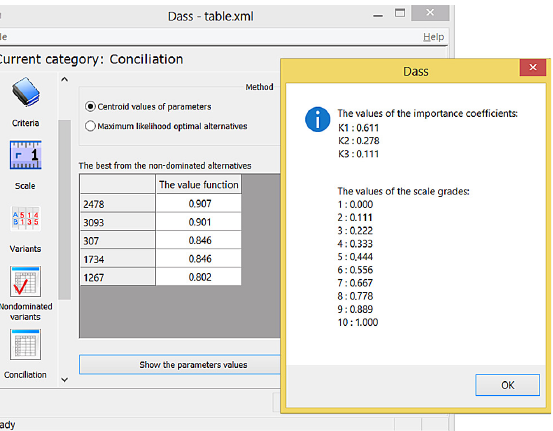
Figure 6. Estimation of value functions based on the centroid values of the decision maker’s prefer- ence